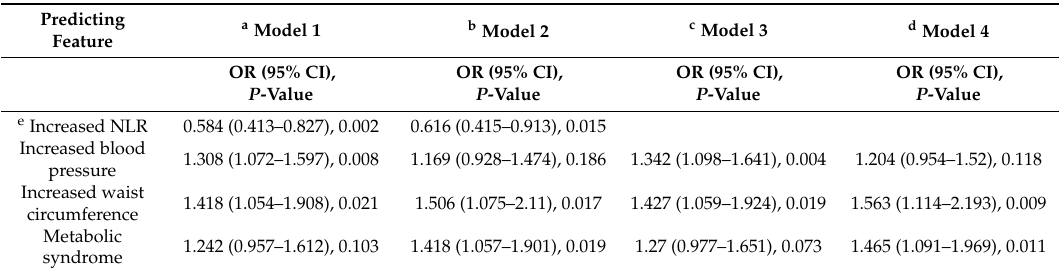
Table 3. Regression models for metabolic risks and metabolic syndrome with the SNP rs76181728 used as the dominant